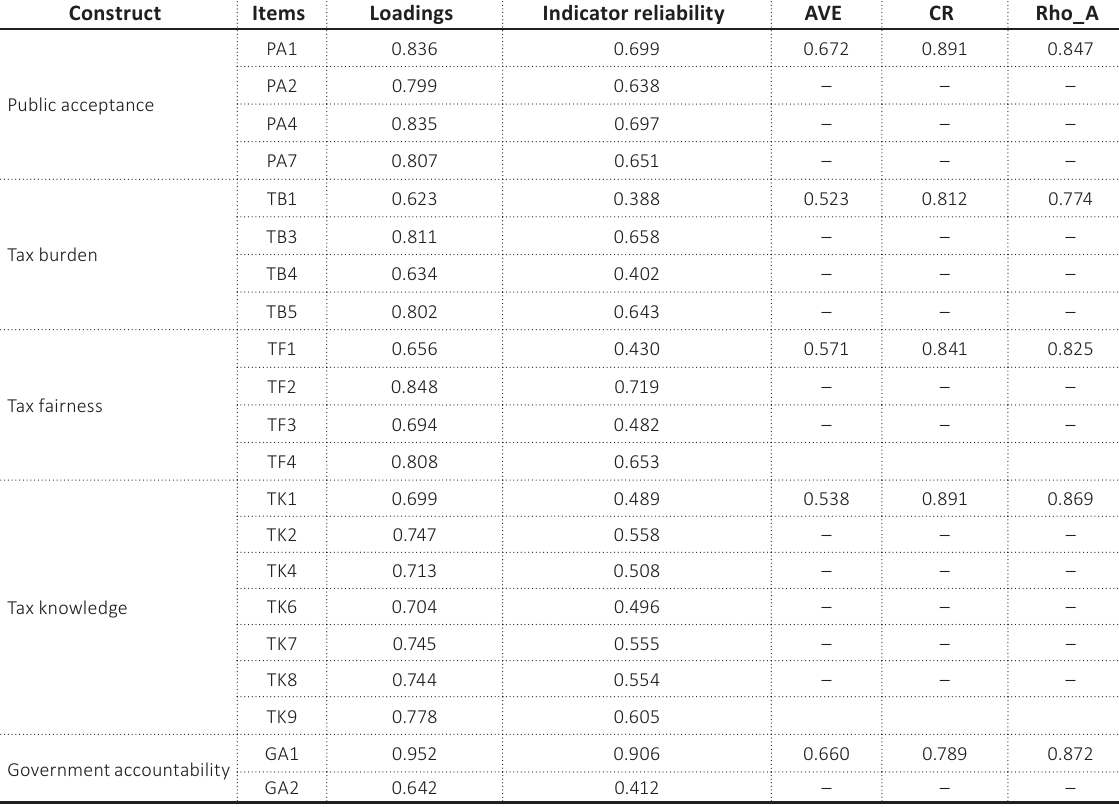
Table 2. Key quality criteria of the reflective measurement model Construct